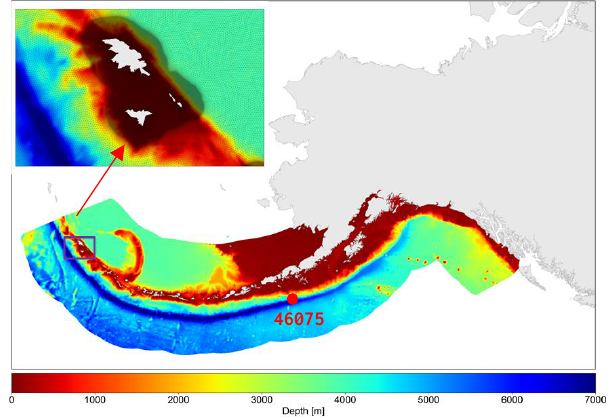
Fig. 4. UnSAWN model domain and grid for U.S. Alaska